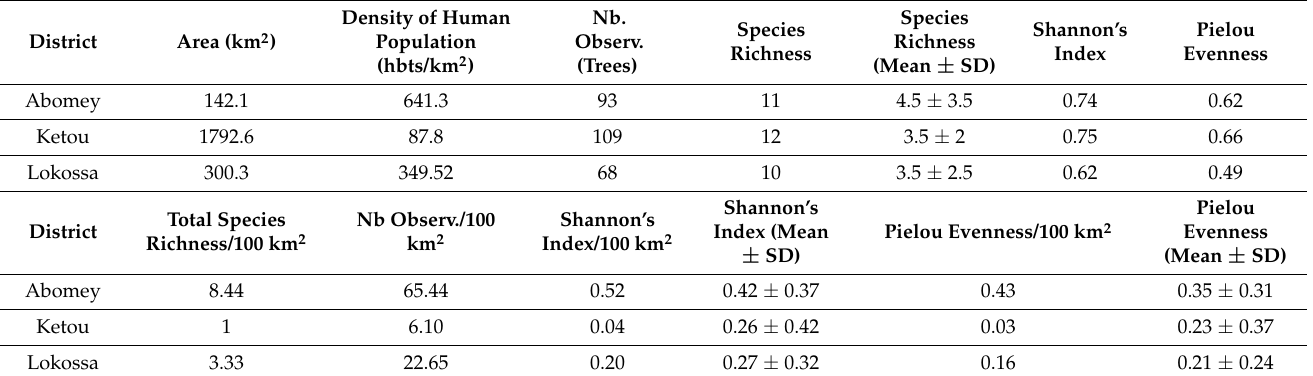
Table 4. Diversity indices and observation in terms of the number of LOTs by district based on the area of the district (top panel). Diversity indices and observation in terms of the number of LOTs by district based on a unit area of 100 km 2 (bottom